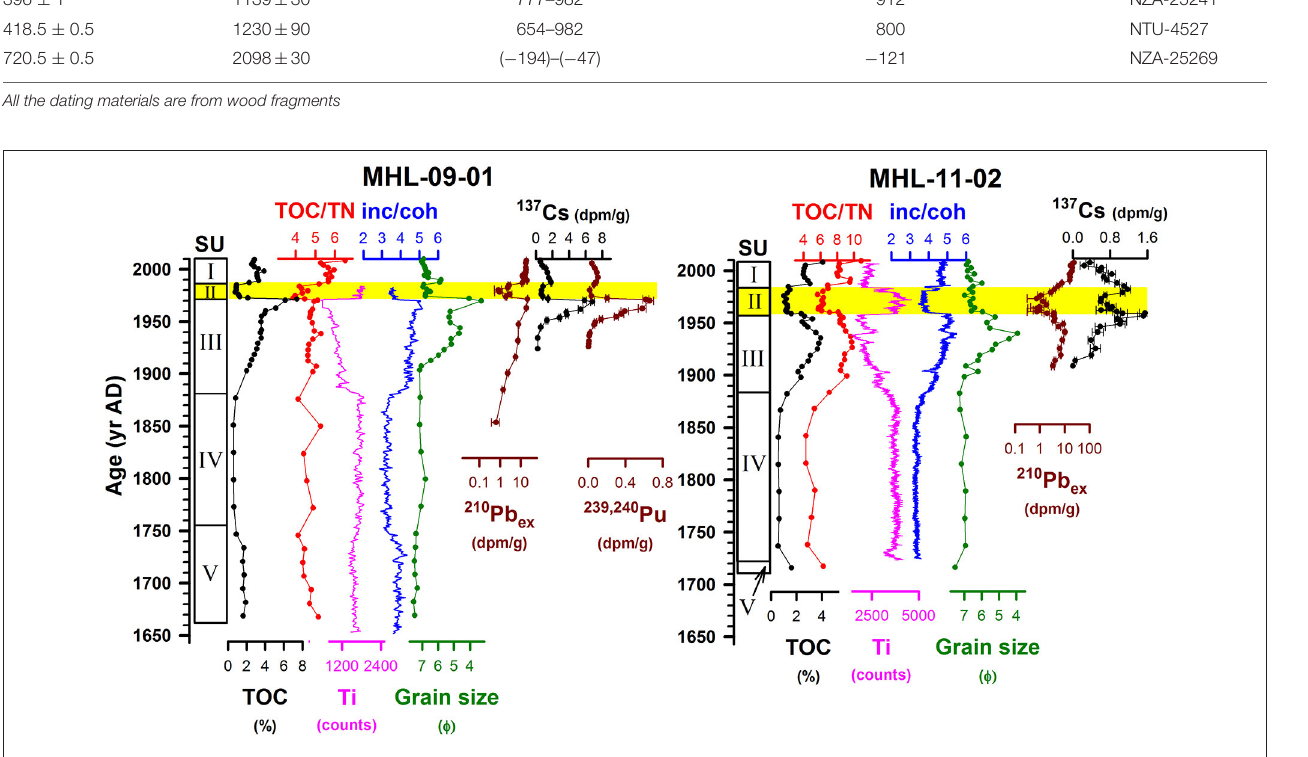
FIGURE 3 | Sediment geochemical records of core MHL-09-01 and MHL-11-02. SU (Sedimentary units), TOC (%, total organic carbon), TOC/TN, inc/coh (organic indicator obtained by Itrax-XRF core scanner), grain size and radionuclides are shown. The interval highlighted by the yellow bars can be related to the erosion caused by the construction of a San-Chin-Gong Temple complex on the hillslope south of the lake from AD 1970 to 1982. The increase in organic matter in Unit III likely represents the land development by Chinese settlers in the late 19th